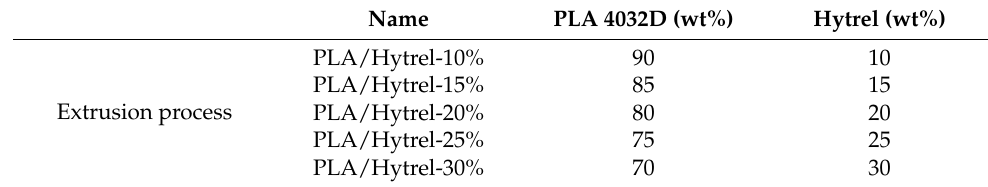
Table 1. Compositionof different PLA/Hytrel compoundsthat were preparedusing anextrusion